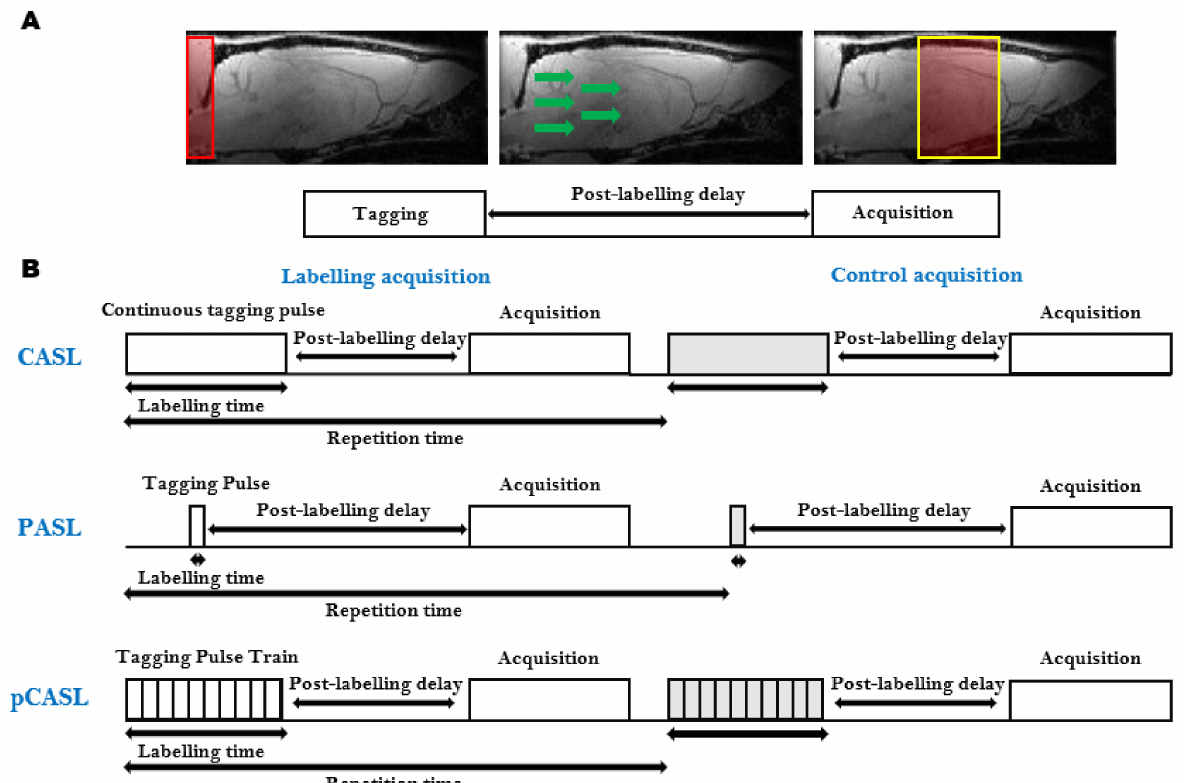
Figure 3. Arterial Spin Labeling (ASL): ( A ) The general ASL scheme consists of two consecutive acquisitions. The first acquisition consists of the tagging of the arterial blood spins (Left), followed by a post-labeling delay time, during which the tagged spins flow to the tissue of interest and exchange with the stationary spins in the extravascular-extracellular space (Middle), and finally, the image is acquired (Right). The second acquisition, which serves as a control, is identical to the first acquisition without the tagging of the arterial water spins; ( B ) Schematic representation of the most widely used ASL sequences. Continuous ASL (CASL), uses a continuous Radiofrequency (RF) pulse in combination with a constant imaging gradient in the direction of the arterial blood flow to invert the water spins of arterial blood (Top). In Pulsed ASL (PASL), the labeling is achieved using a pulse or a pulse train of short RF inversion pulses (Middle). pseudo-Continuous ASL (pCASL) uses a train of short RF pulses that mimic the long continuous RF pulse from CASL